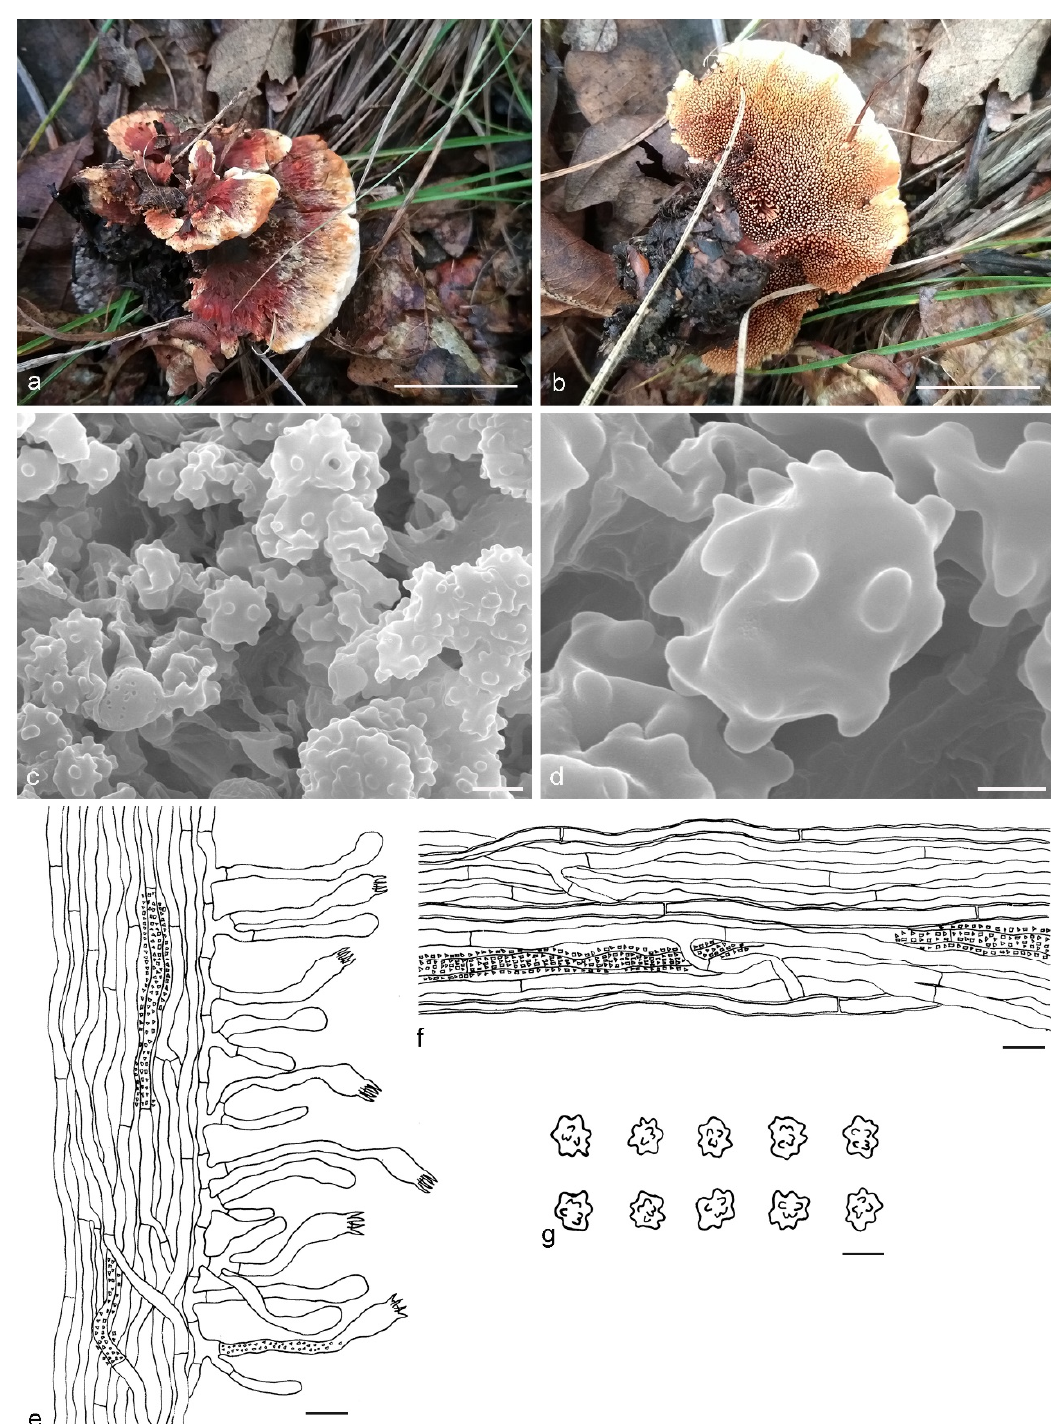
Figure 4. Hydnellum brunneorubrum. ( a , b ): Basidiocarps; ( c , d ): SEM of basidiospores; ( e – g ): Microscopic structures (drawn from IFP 019384); ( e ): Section of hymenophore trama with basidia; ( f ): Hyphae from pileus context; ( g ): Basidiospores. —Scale bars: ( a , b ) = 1 cm; ( c ) = 3 μm; ( d ) = 1 μm; ( e , f ) = 10 μm; ( g ) = 5 μm.